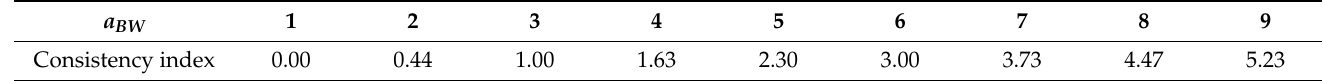
Table 6. Consistency index.